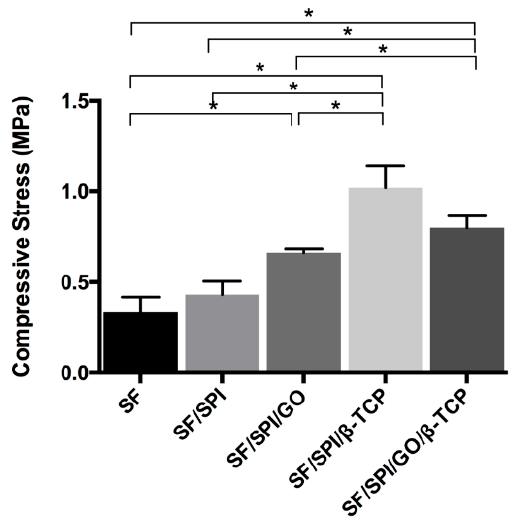
Figure 3. Mechanical properties of the SF/SPI-based composite scaffolds. Statistical significance relative to each group: * p < 0.05.